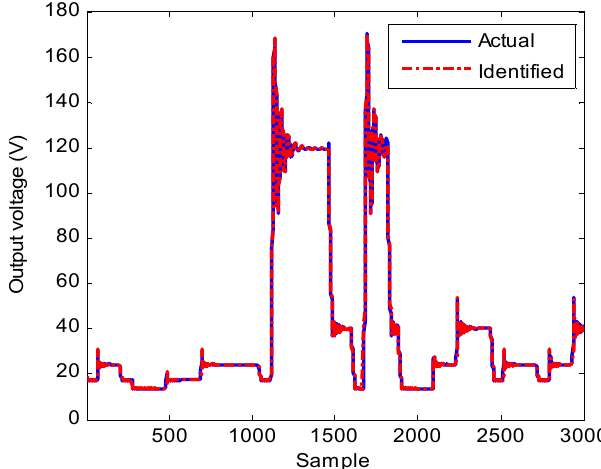
Figure 5. Identification results for the test dataset. Table 1. Clean and noisy measurement data comparison of the LMN performance.